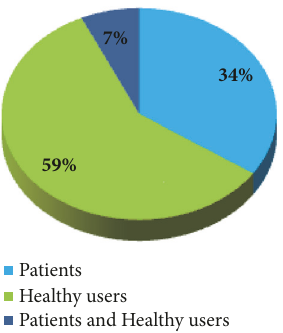
Figure 6: Profile of the users who did the experiments.